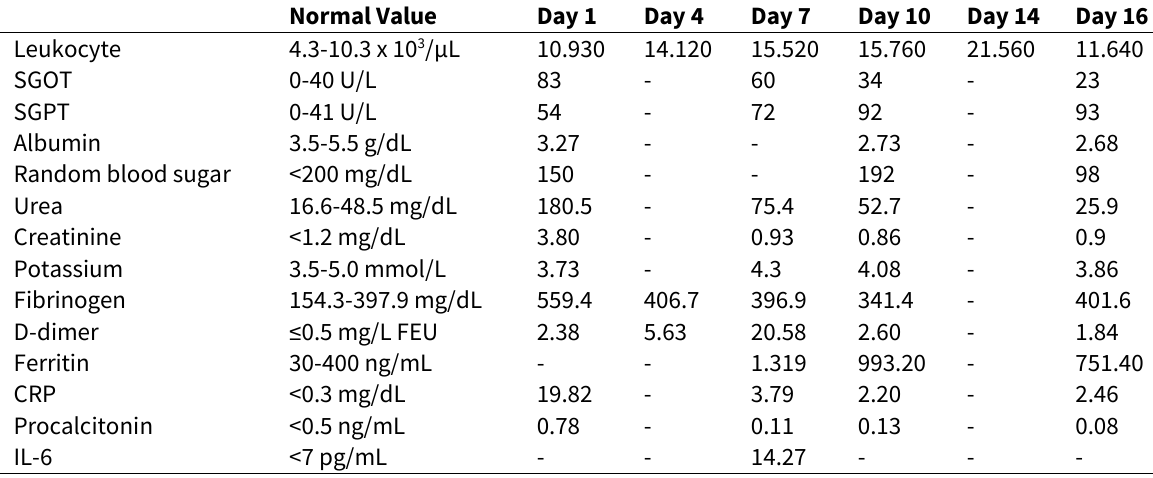
Table 3. Results of Monitoring Laboratory Examinations for third